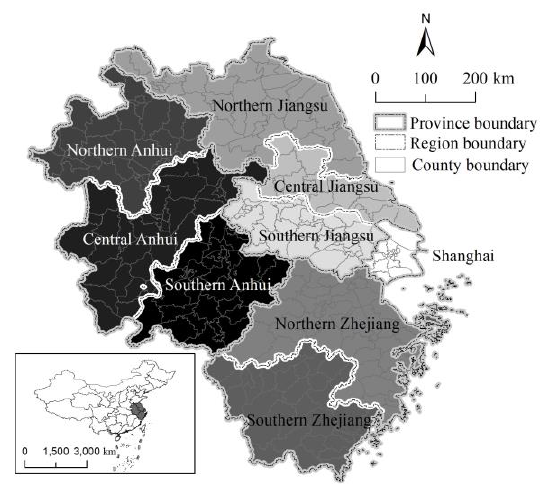
Figure 1. Location and organization of the YRD.